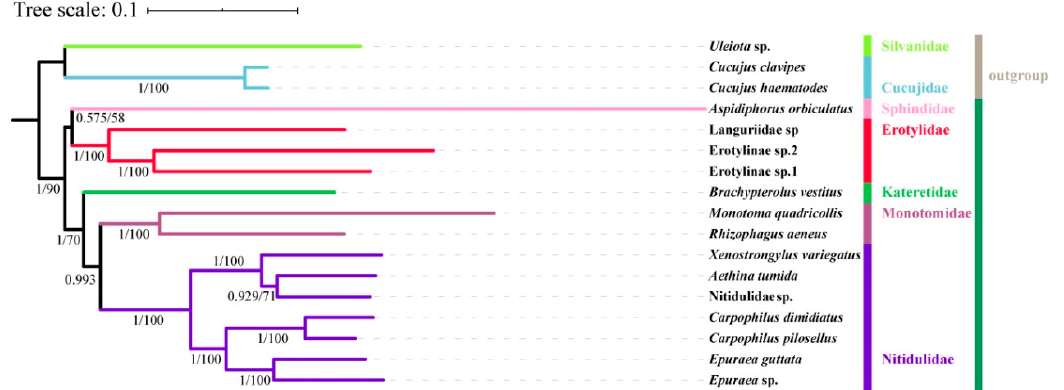
Figure 9. Phylogenetic tree produced from Maximum likelihood (ML) and Bayesian inference (BI) analyses based on PCG12R. The numbers on branches are bootstrap value (BS) and Bayesian posterior probabilities (PP).